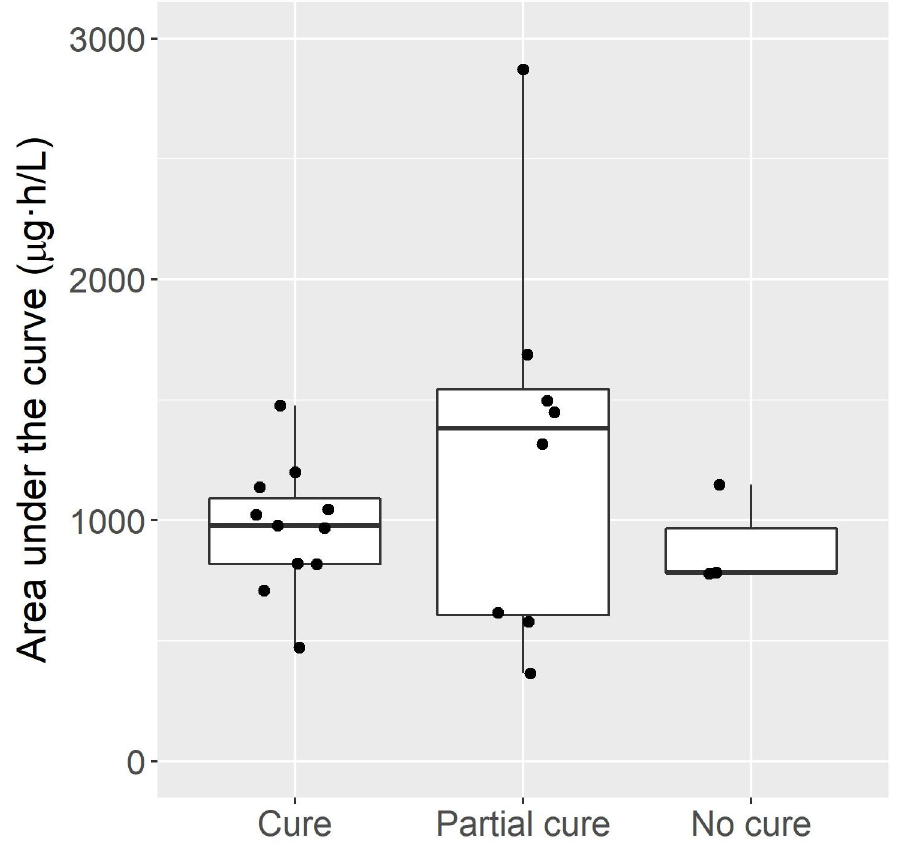
Fig 2. Drug exposures (area under the curve) vs clinical responses from children enrolled in the current study.